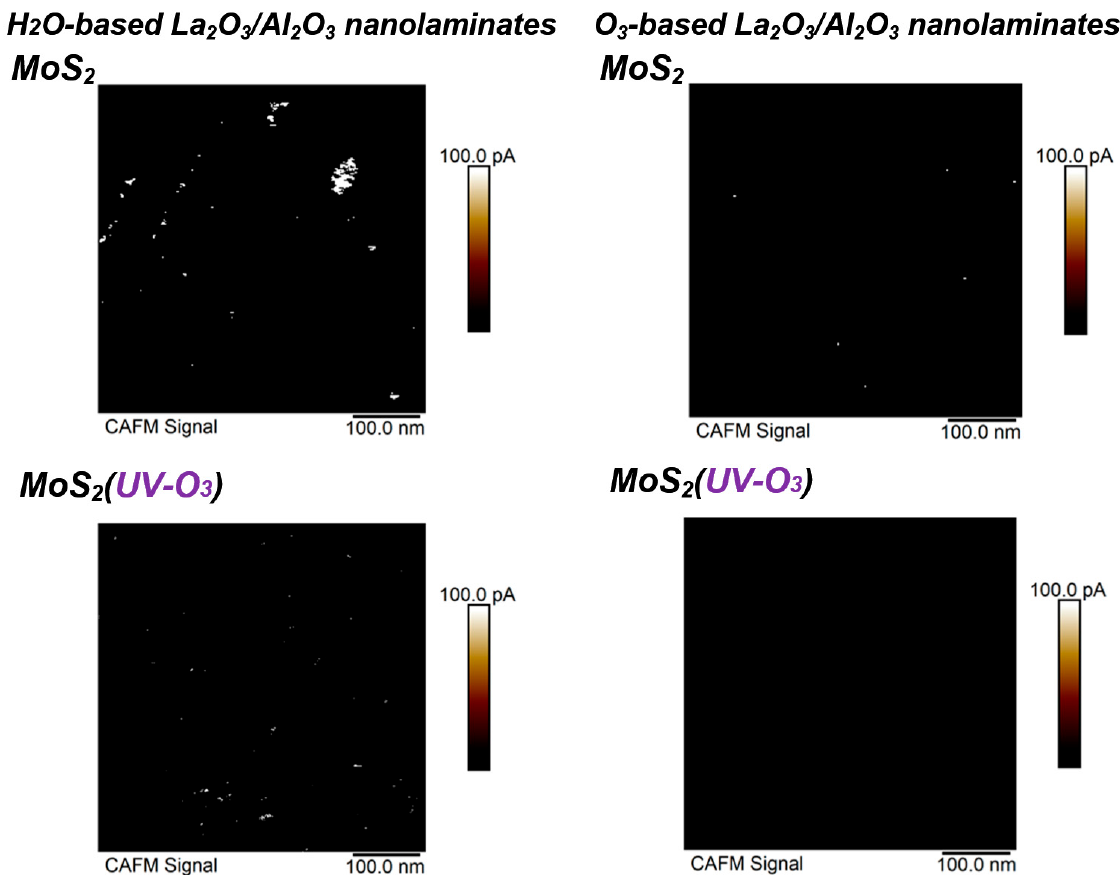
Figure 3. Conductive AFM images of sub-5 nm La 2 O 3 /Al 2 O 3 nanolaminates on MoS 2 with or without UV-O 3 treatment .